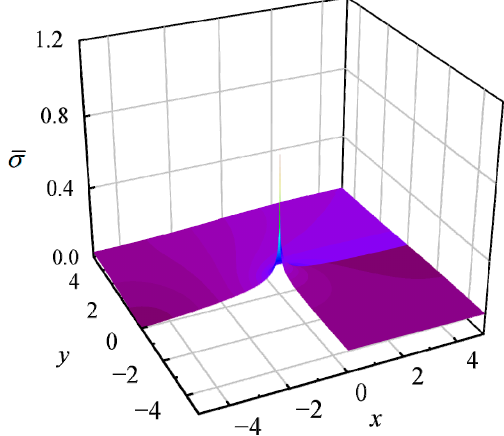
Figure 20. Distribution of effective gradient.